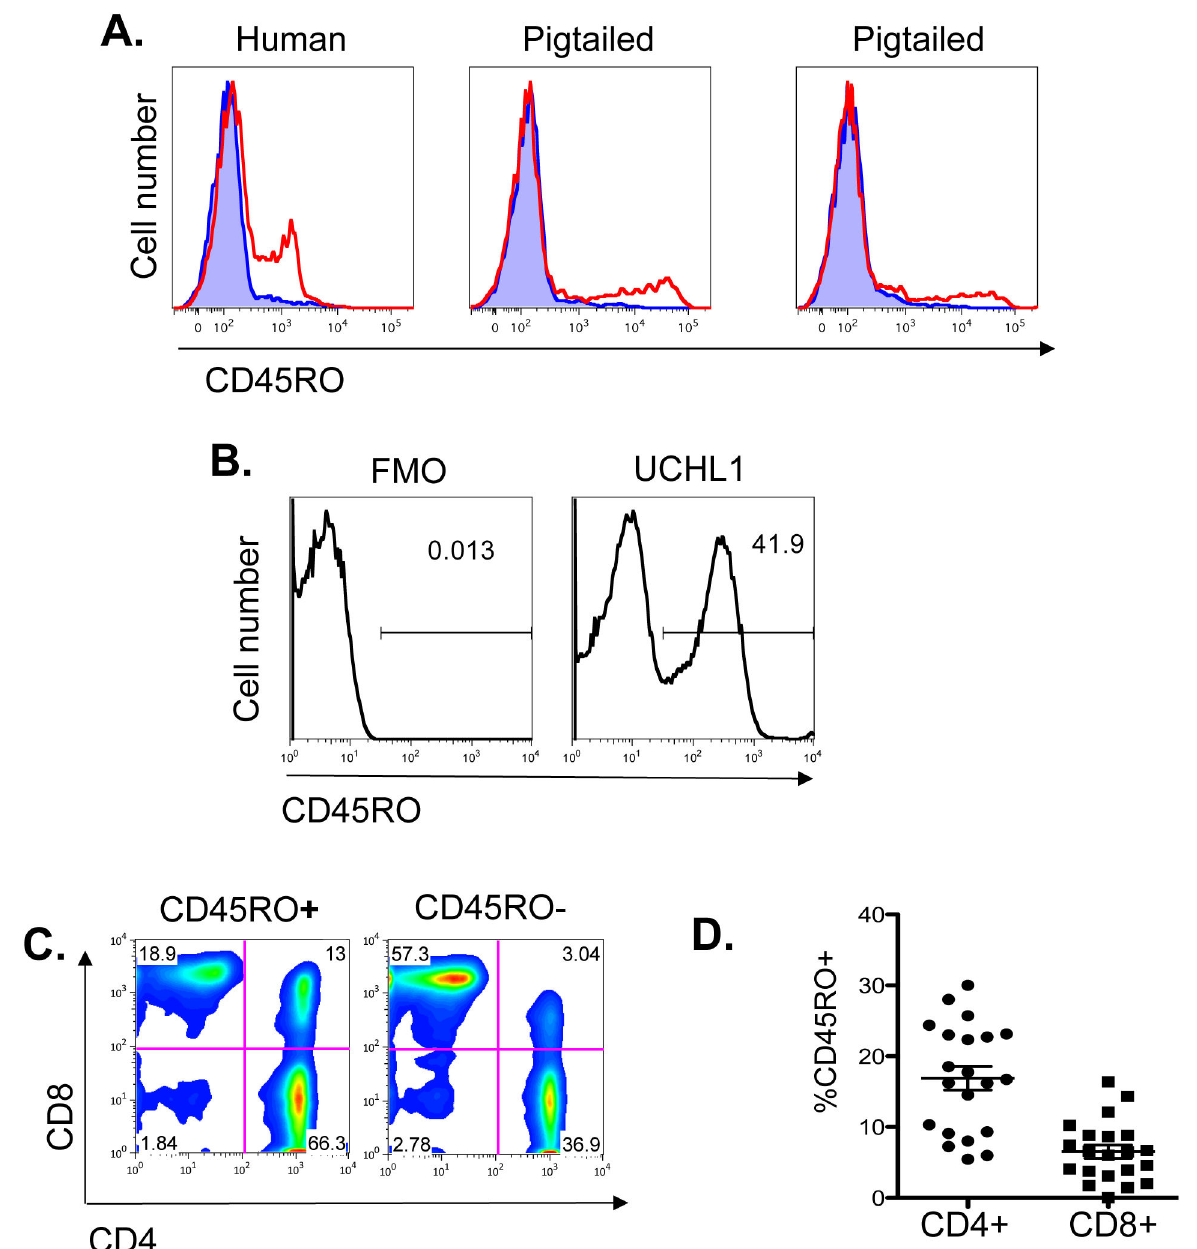
Figure 1. Expression of CD45RO on PBMC of pigtailed macaques. Flow cytometry was performed on freshly isolated PBMC. A . CD45RO was detected by indirect immunofluorescence on PBMC from two uninfected pigtailed macaques and for comparison, a human sample. Cells were gated on singlets and lymphocytes by light scatter. Murine IgG2a isotype controls are shown in blue. Data represent 1 of 3 independent experiments. B – D . Direct immunofluorescent staining of PBMC with a panel of Abs to CD3, CD4, CD8, and CD45RO. Cells were gated on lymphocytes by light scatter, then on CD3+. Panel B shows fluorescence minus one (FMO) control used to determine the CD45RO gate (left) and UCHL1 stained sample (right) in a SHIV-infected macaque (representative of 2 independent experiments). In panel C, we examined CD4 and CD8 on T-cells gated for CD45RO expression (one of 21 macaques so tested). The proportion of CD4 or CD8 PBMCs expressing CD45RO in 21 SHIV-infected macaques is shown in panel D.